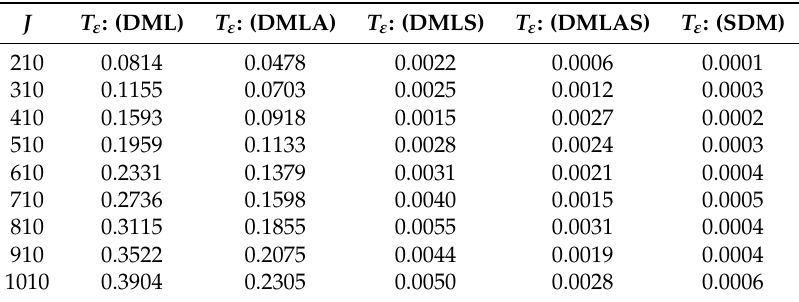
Table 5. Results for Case QL with m = 25, ε = 10 − 2 .